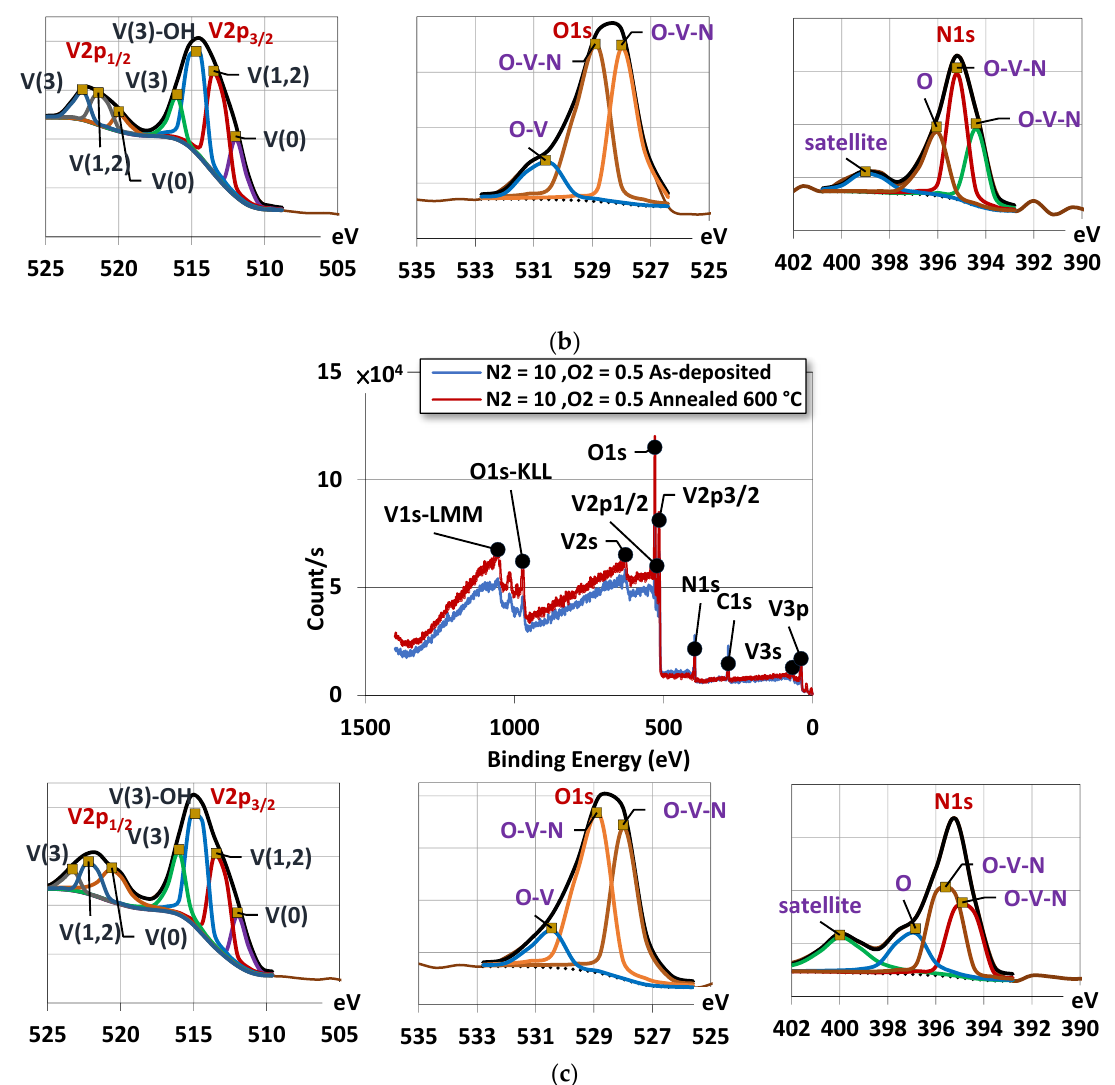
Figure 4. XPS of annealed films at 600 °C for different oxygen/nitrogen flow rates. ( a ) O 2 /N 2 = 0.15/3 sccm, ( b ) O 2 /N 2 = 0.25/5 sccm, and ( c ) O 2 /N 2 = 0.5/10 sccm.